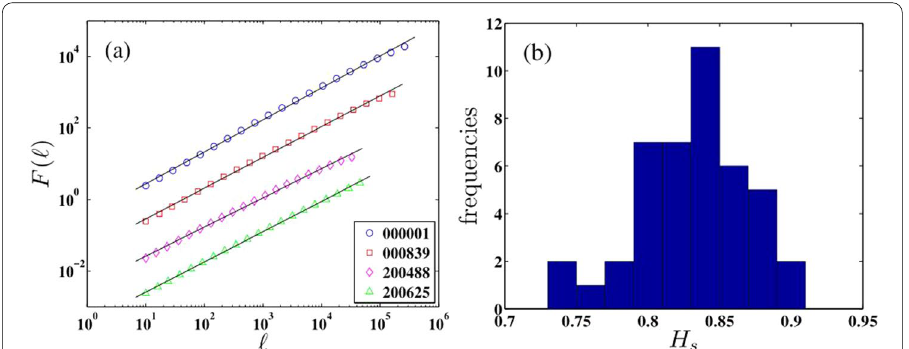
Fig. 1 Long memory in order directions. a Plots of the fluctuation functions F (ℓ) of order directions for four stocks 000001, 000839, 200488 and 200625. The solid lines are the least squares fits to the data. The scaling curves for 000839, 200488 and 200625 have been shifted vertically for clarity. b Histograms of Hurst exponents H s of order directions for all the 43